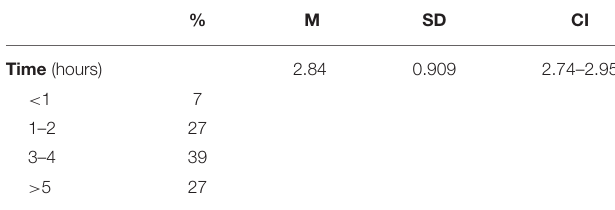
TABLE 2 | Daily usage of social media ( n =